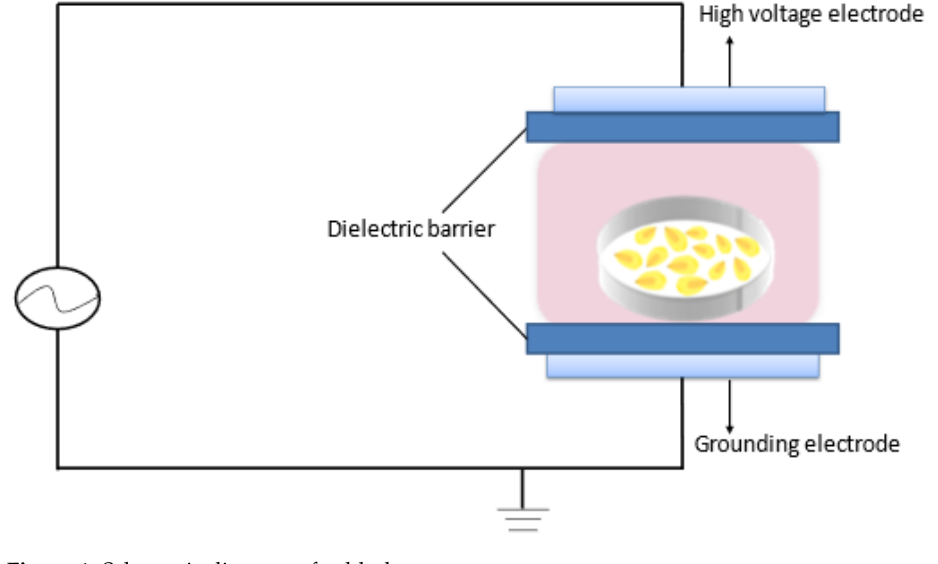
Figure 1. Schematic diagram of cold plasma .